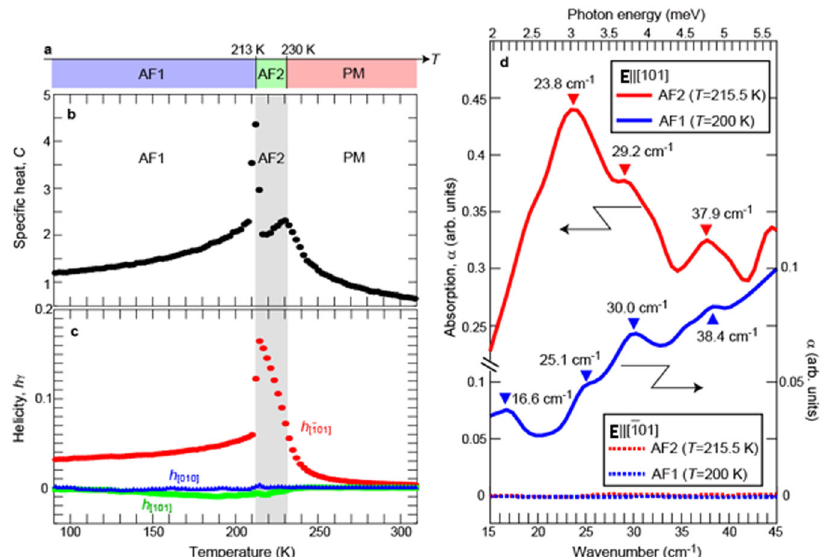
Fig. 4 Theoretical magnetic phase diagram and simulated absorbance response of the electromagnons in the THz energy range. a Theoretical phase diagram of CuO as a function of temperature. b Temperature pro fi le of speci fi c heat C . c Temperature pro fi les of the (cid:5) h (cid:3) E ≡ h ⋅ e ≡ h ⋅ e components of spin helicity vector h ½ ½ 101 (cid:2) , h [101] [101] , and h [010] [010] , where e ½ 101 (cid:2) , e [101] and e [010] are unit directional 101 (cid:2) vectors in respective directions. d Absorbance spectra α ( ω ) for the AF2 phase ( T = 216 K) and the AF1 phase ( T = 200 K) for two in-plane light polarizations E ω ∥ [101] and E ω k½ 101 (cid:2) . The spectra are calculated by assuming the antisymmetric exchange-striction mechanism ( S × S mechanism) for the spin-dependent electric